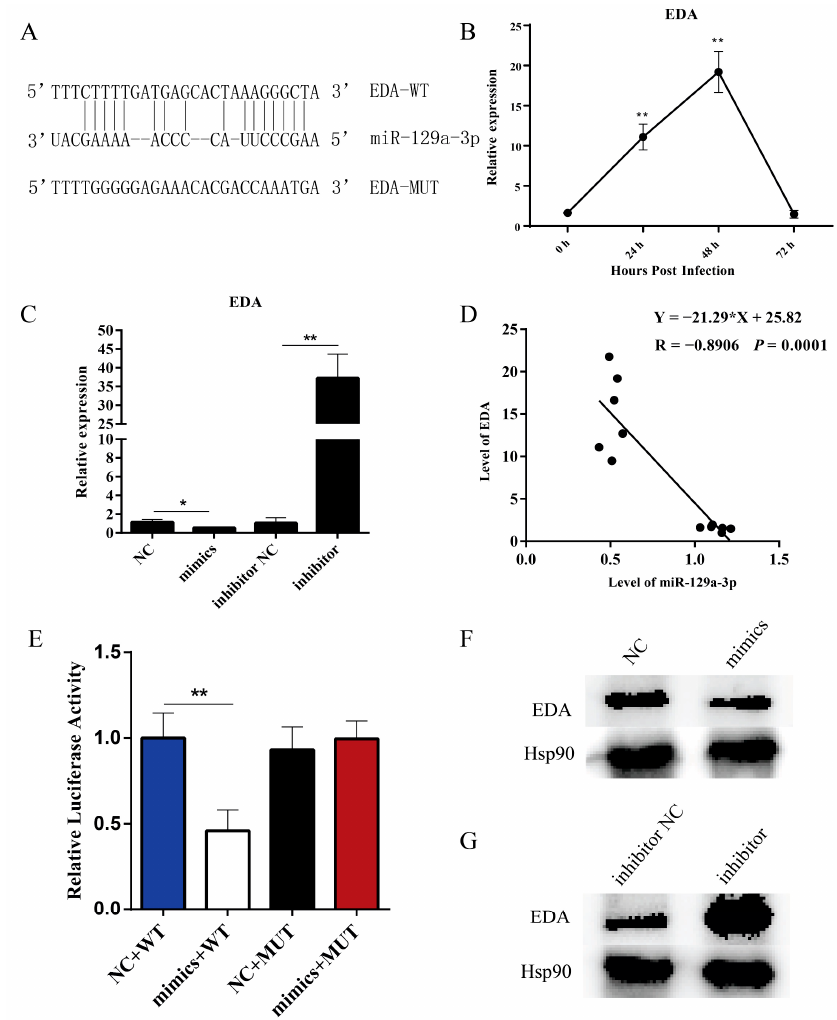
Figure 2. miR-129a-3p targets EDA . ( A ) miR-129a-3p and EDA complementary sequence and EDA mutant sequence. ( B ) Expression changes of the EDA gene after IPEC-J2 infection by PEDV. ( C ) Expression levels of the EDA gene in different treatment groups. ( D ) Expression correlation analysis between miR-129a-3p and EDA . ( E ) Dual luciferase assay was per- formed to verify the targeting relationship between miR-129a-3p and EDA . ( F ) Expression levels of intracellular EDA protein after miR-129a-3p mimics treatment. ( G ) Expression levels of intracellular EDA protein after miR-129a-3p inhibitor treatment. The * denotes a significant difference with p < 0.05, while the ** denotes a significant difference with p < 0.01.